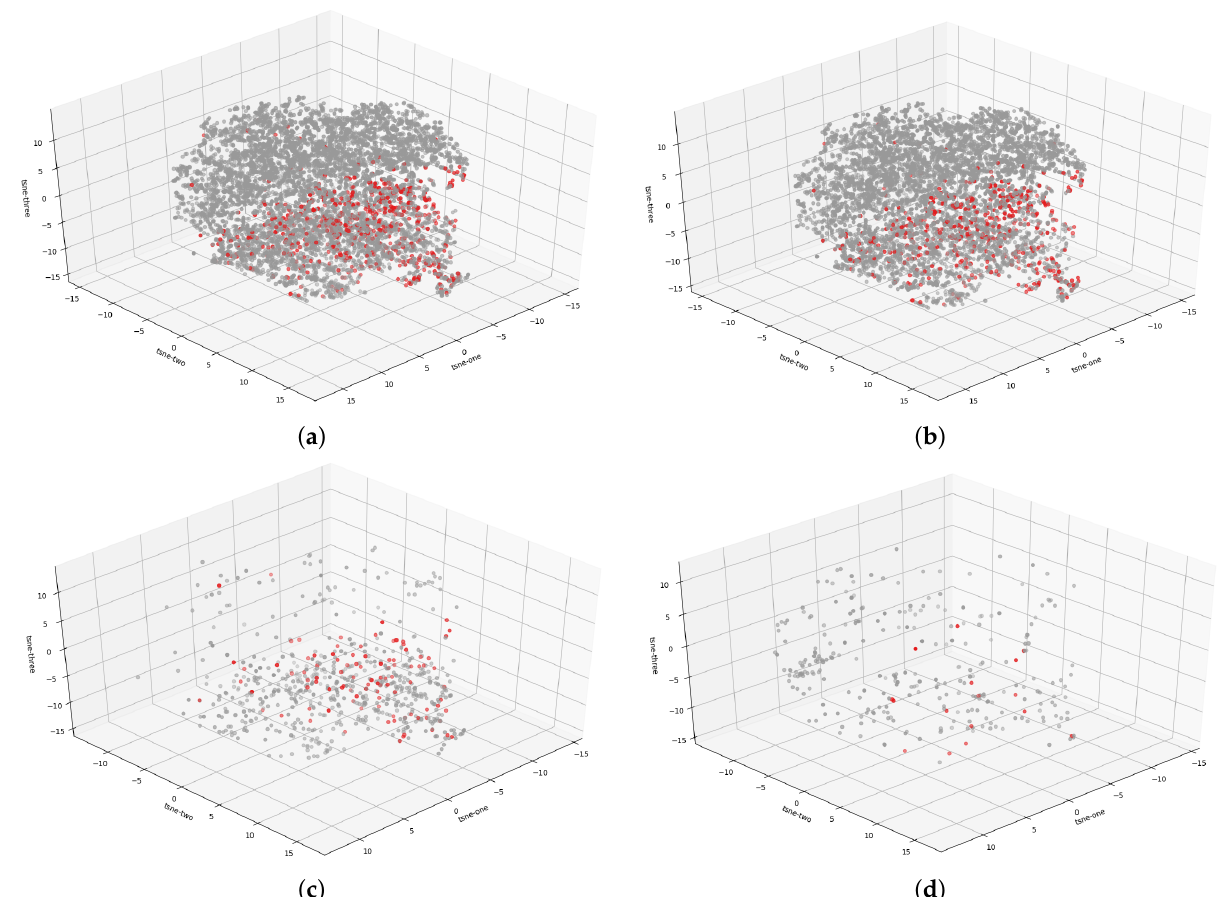
Figure 3. Interpretation of the 3D t-SNE plot visualization of the HAM10000 dataset where the red dots indicate melanoma cases while gray dots represent benign lesions. The following figures present the distribution of malignant and benign cases for the ( a ) entire dataset, ( b ) trunk-extremities dataset, ( c ) face-head dataset, and ( d ) acral